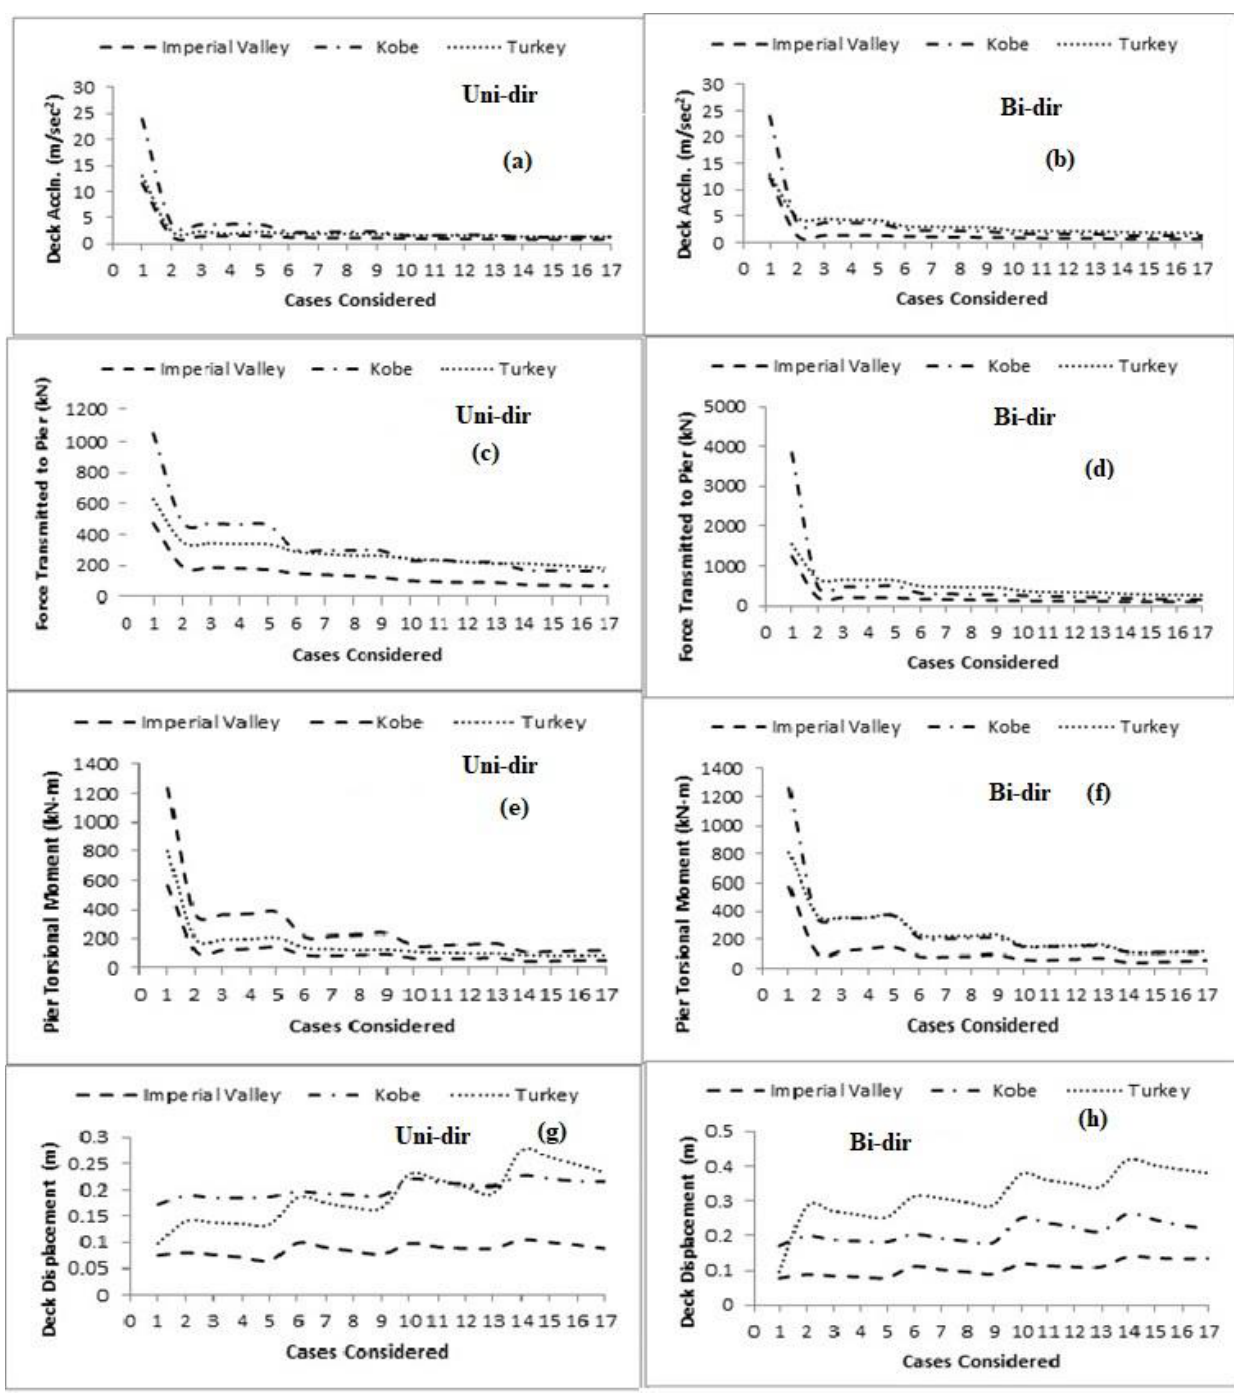
Figure 13. Peak response of the bridge (i) Deck Acceleration ( a , b ), (ii) Force Transmitted to Pier ( c , d ), (iii) Pier Torsional Moment ( e , f ) Deck Displacement ( g , h ) for Imperial Valley, Kobe, and Turkey earthquakes.